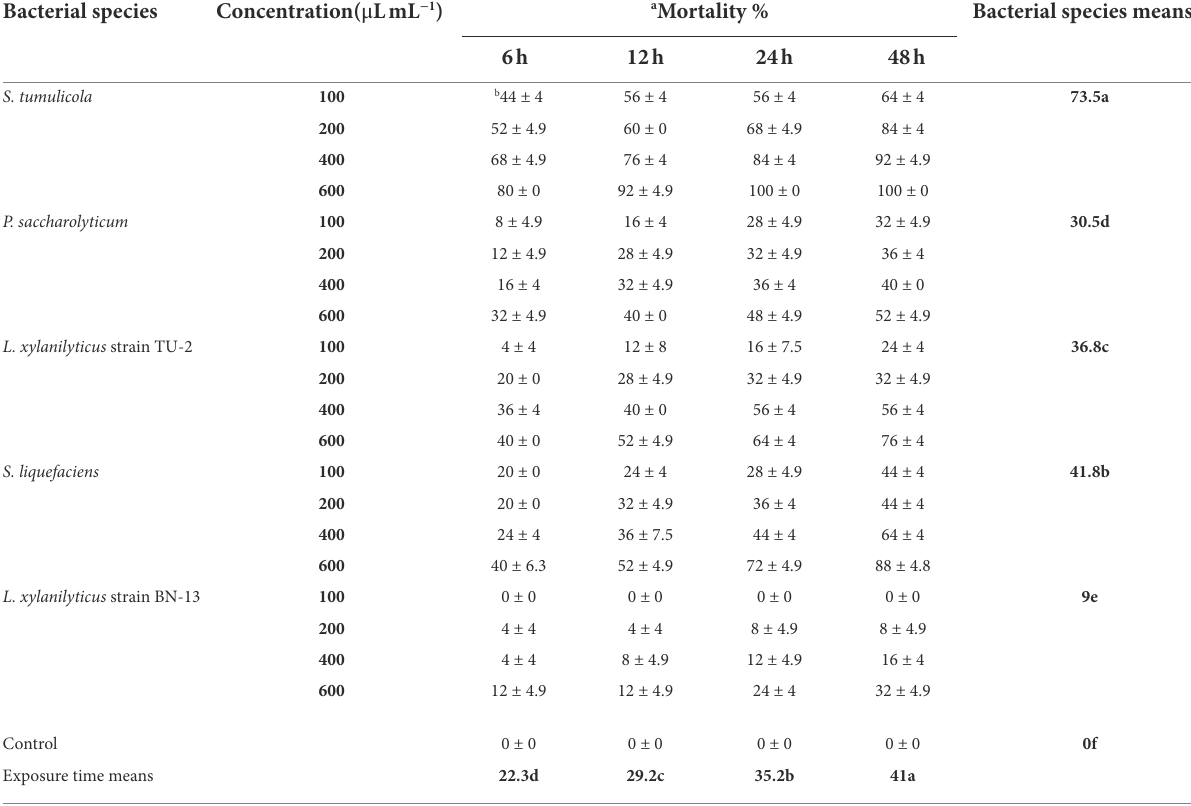
TABLE 6 Aphicidal activity of five bacterial species filtrates on the grapevine aphid, A. illinoisensis under laboratory condition. Bacterial